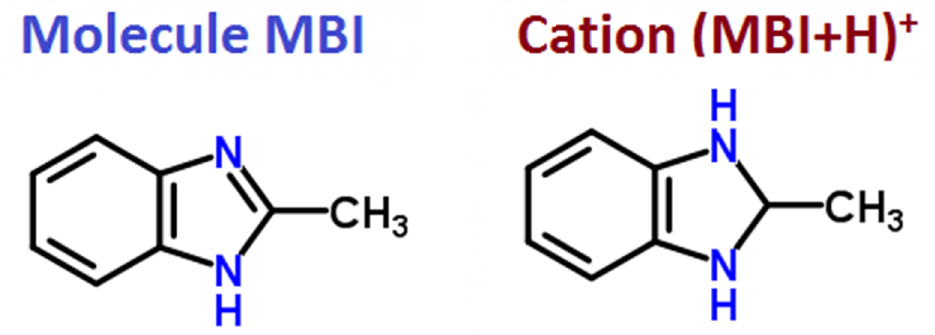
Figure 2. Structural formulas of MBI molecule and cation (MBI + H) + .